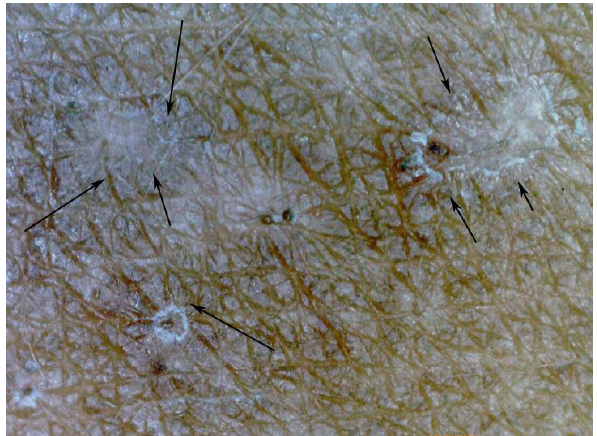
Figure 9. Microscopic circumscribed hyperpigmented areas (arrows) around a sinusoidal tunnel; magnification 30-fold.